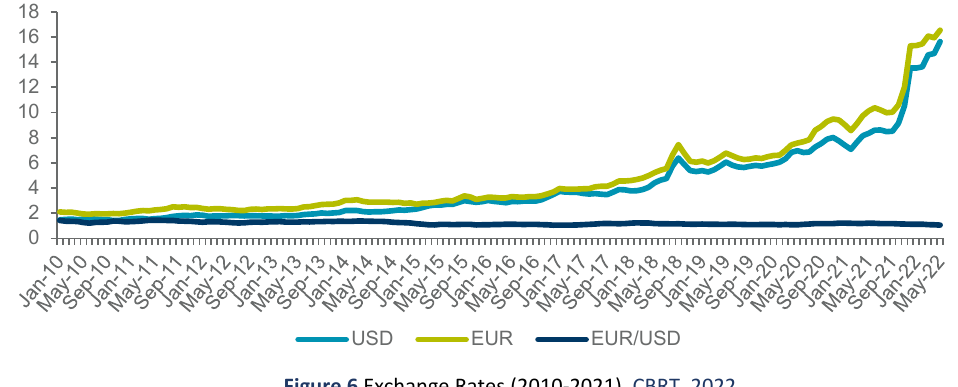
Figure 6 Exchange Rates (2010-2021), CBRT,